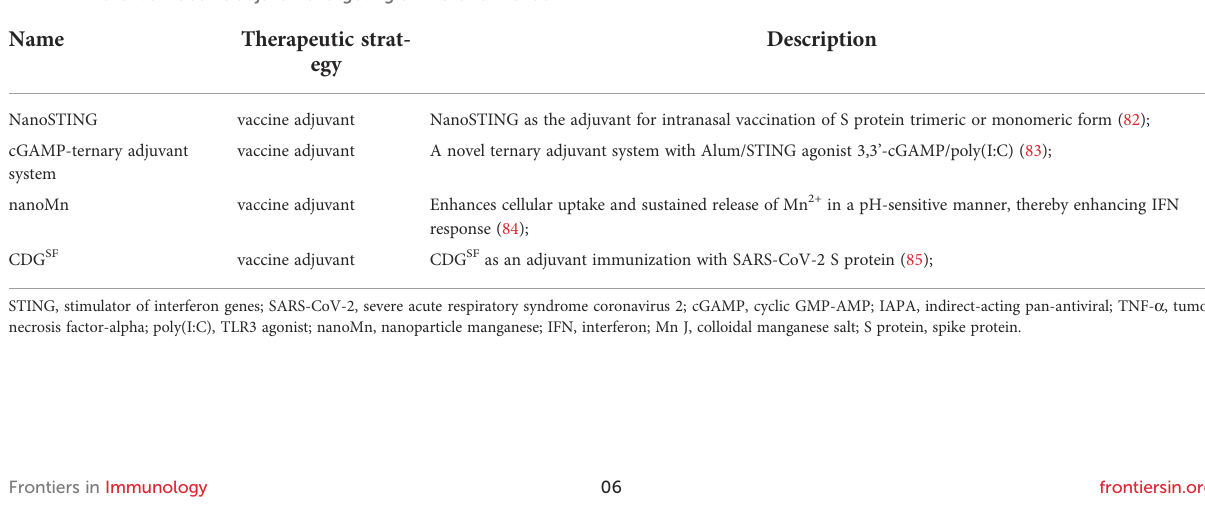
TABLE 2 Potential vaccine adjuvants targeting STING of